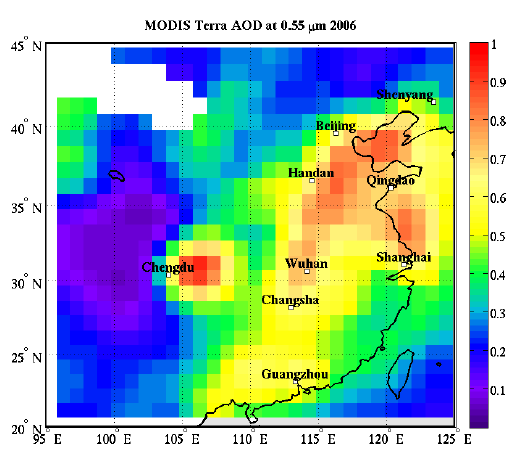
Fig. 7. AOD in China according to MODIS C5 data for 2006 (an- nual average, unitless).